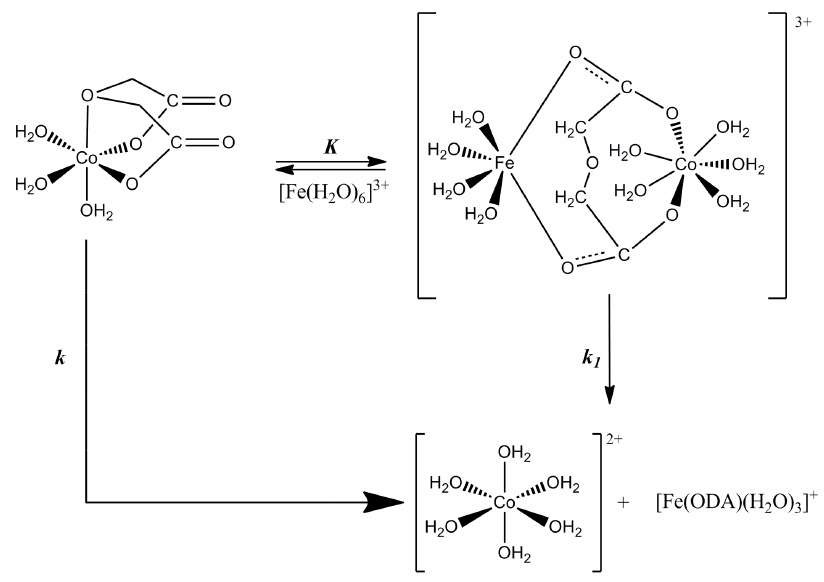
Table 3 : Activation parameters for the aquation of [Co(ODA)(H